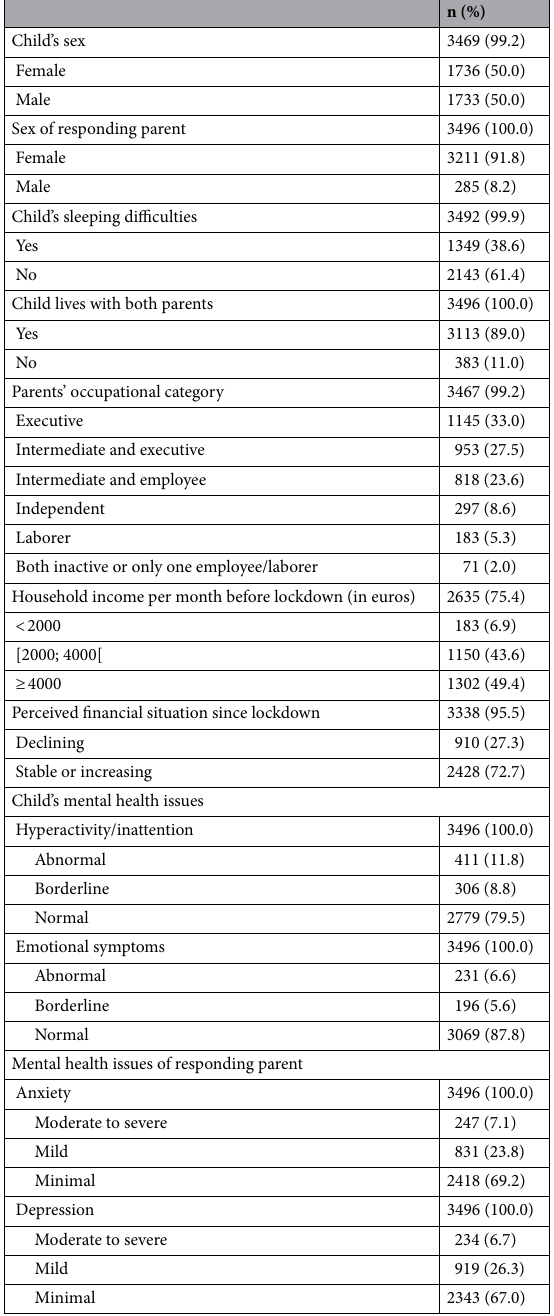
Table 2. Characteristics of children and their families in the ELFE cohort of the SAPRIS study during school closure in France (n =